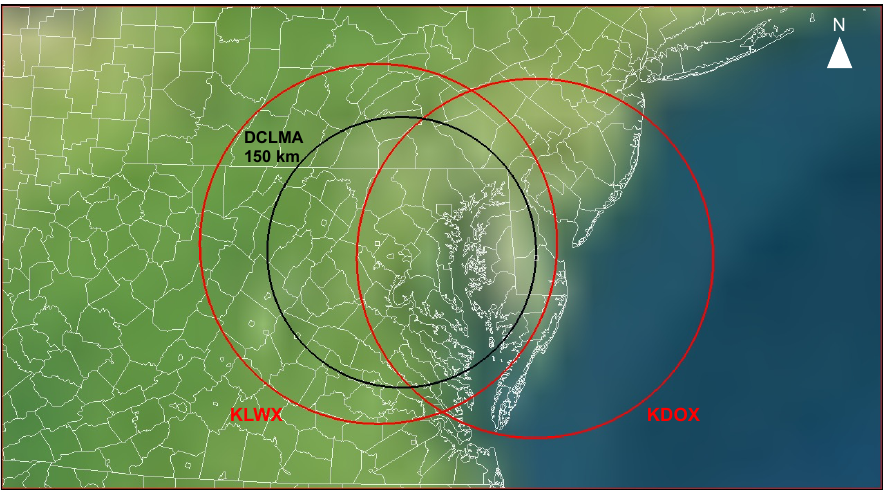
Figure 2. The red circles extend 200 km from the KLWX and KDOX radar sites. All 23 non-severe storms were within 150 km (black circle) of the DCLMA center.